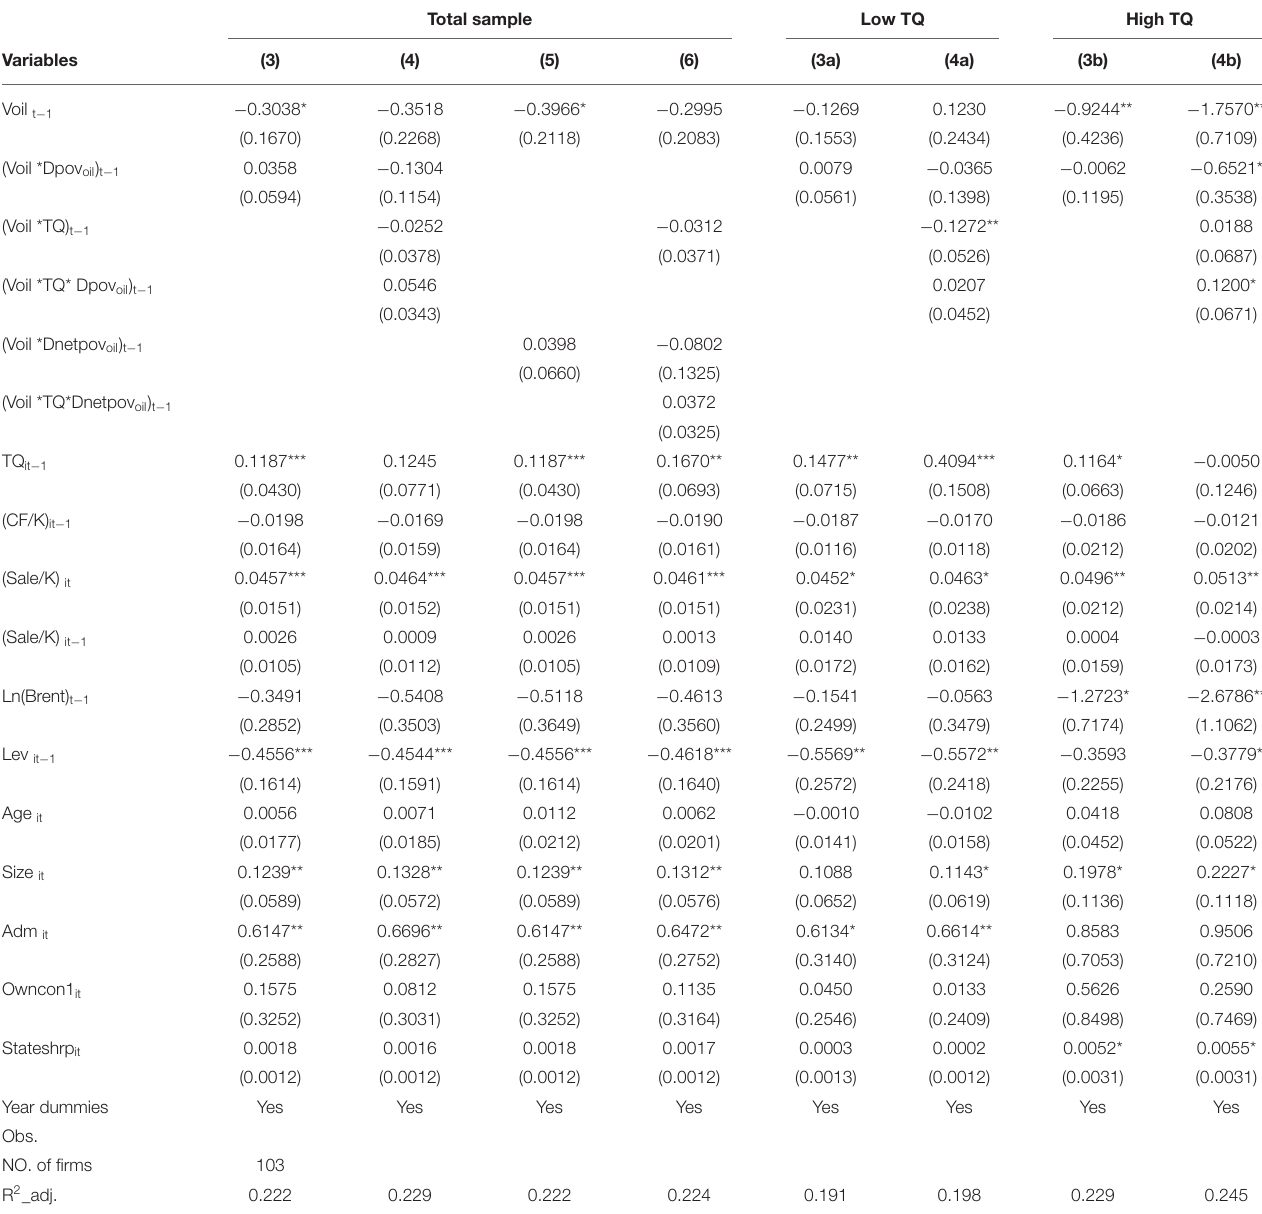
TABLE 3 | The asymmetric effect of oil price uncertainty on investment (Oil price rise or